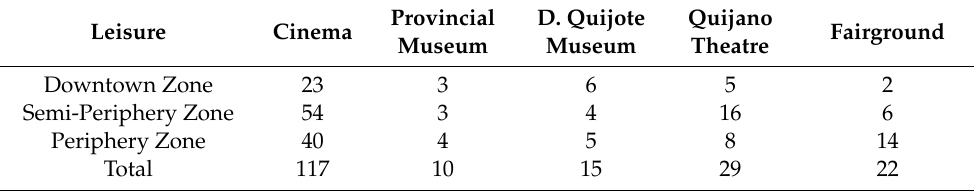
Table A5. Results of answers related to leisure.